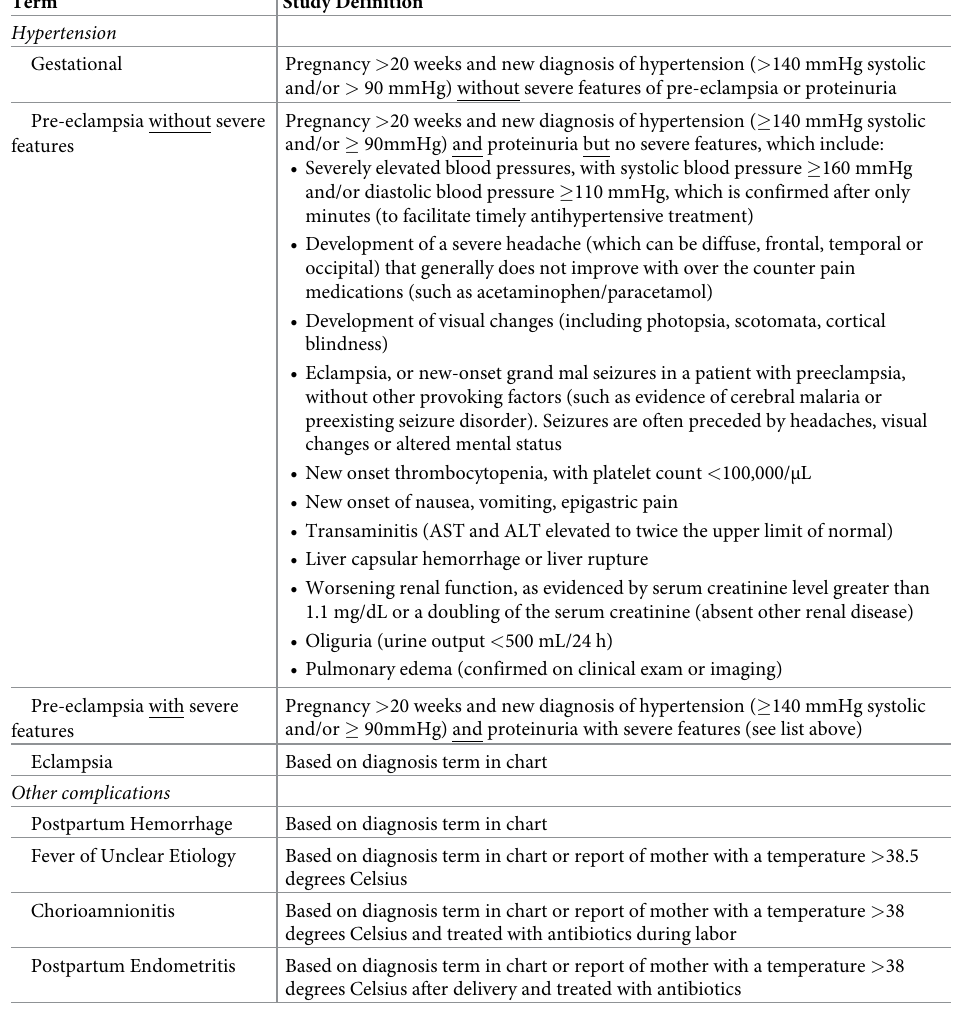
Table 2. Definitions of pregnancy-related